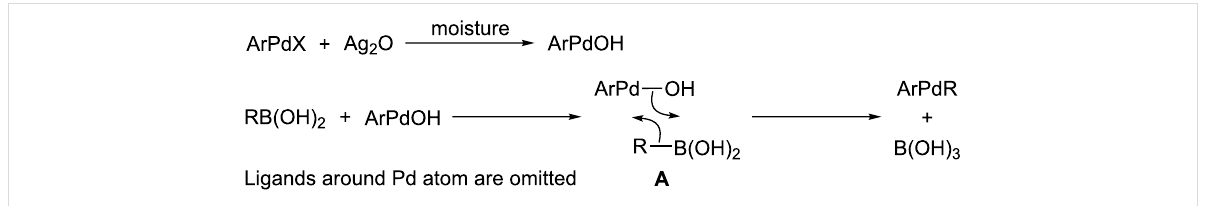
Scheme 1: The assumed silver(I) oxide assisted transmetallation with organoboronic acids.